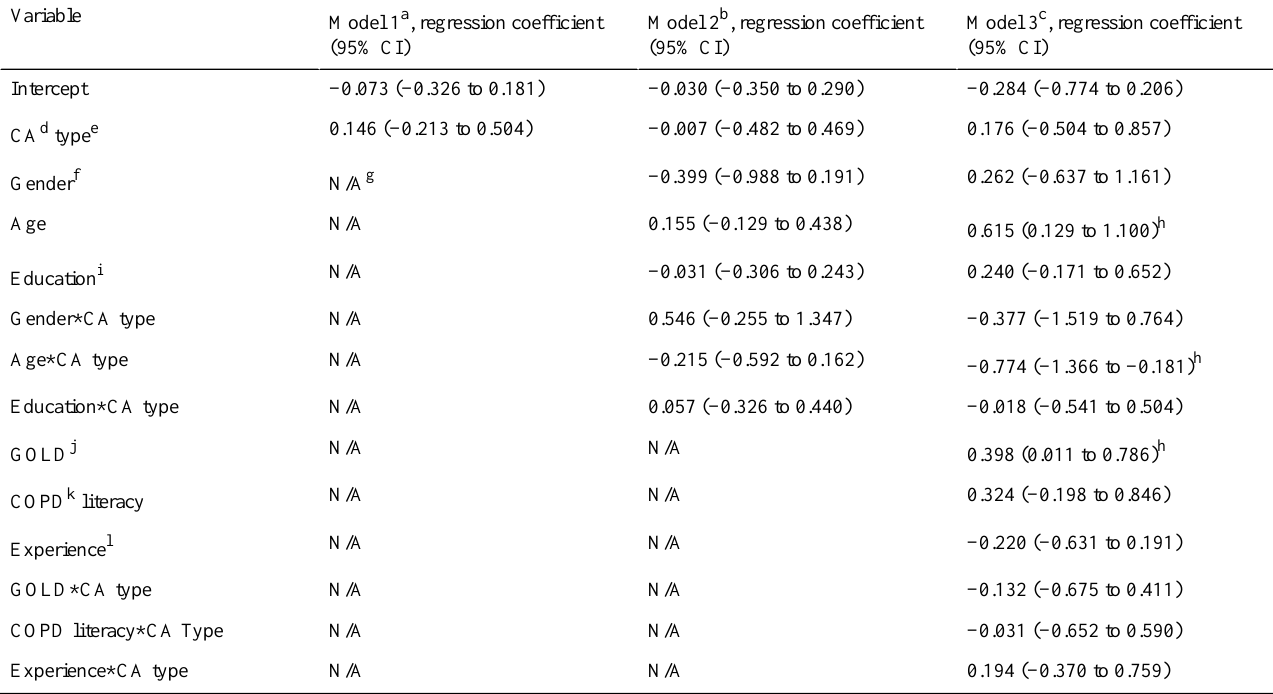
Table 8. Regression of conversational agent type, participants’ demographics, and chronic obstructive pulmonary disease–related characteristics in terms of participants’relationship quality with the conversational